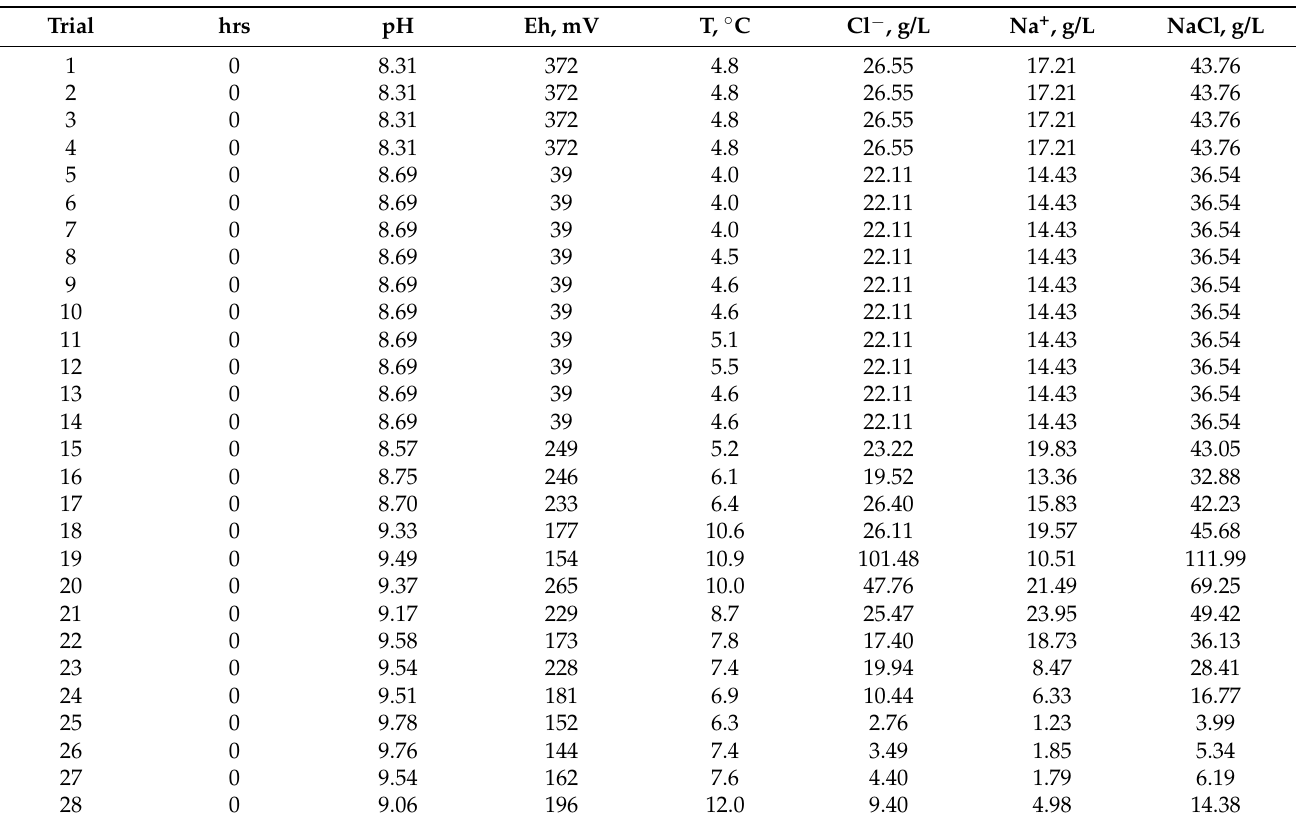
Table A1. Feed water composition for polymer